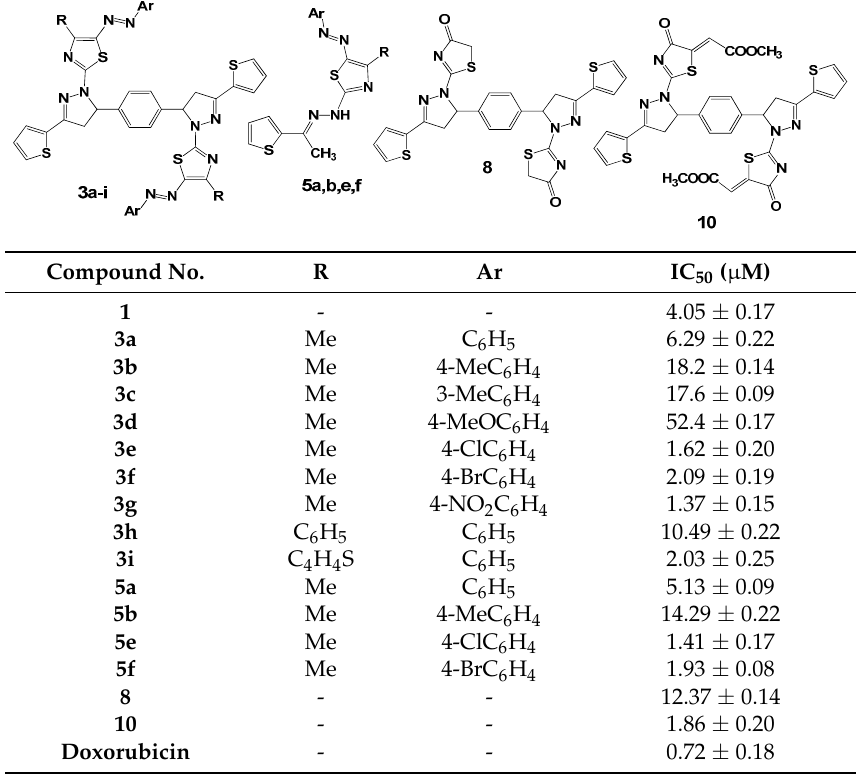
Table 1. The in vitro inhibitory activity of tested compounds against a liver carcinoma cell line HepG2 expressed as IC50 values ( μ M) ± standard deviation from six replicates.